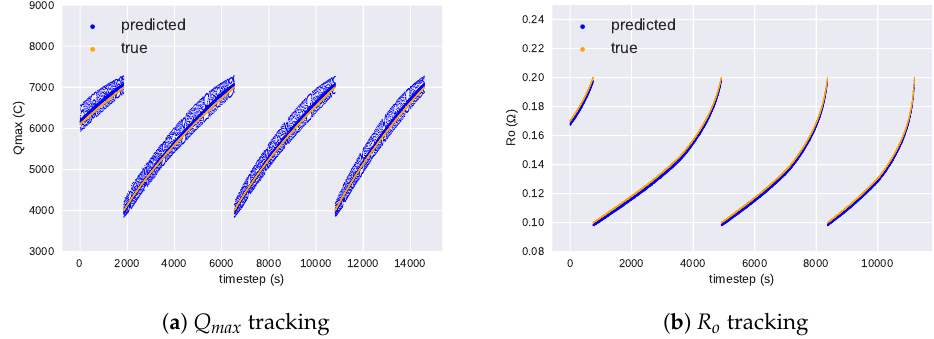
Figure 2. Single parameter inference for Q max and R o using RL. Degradation trajectories from left to right represent increasing input load conditions.